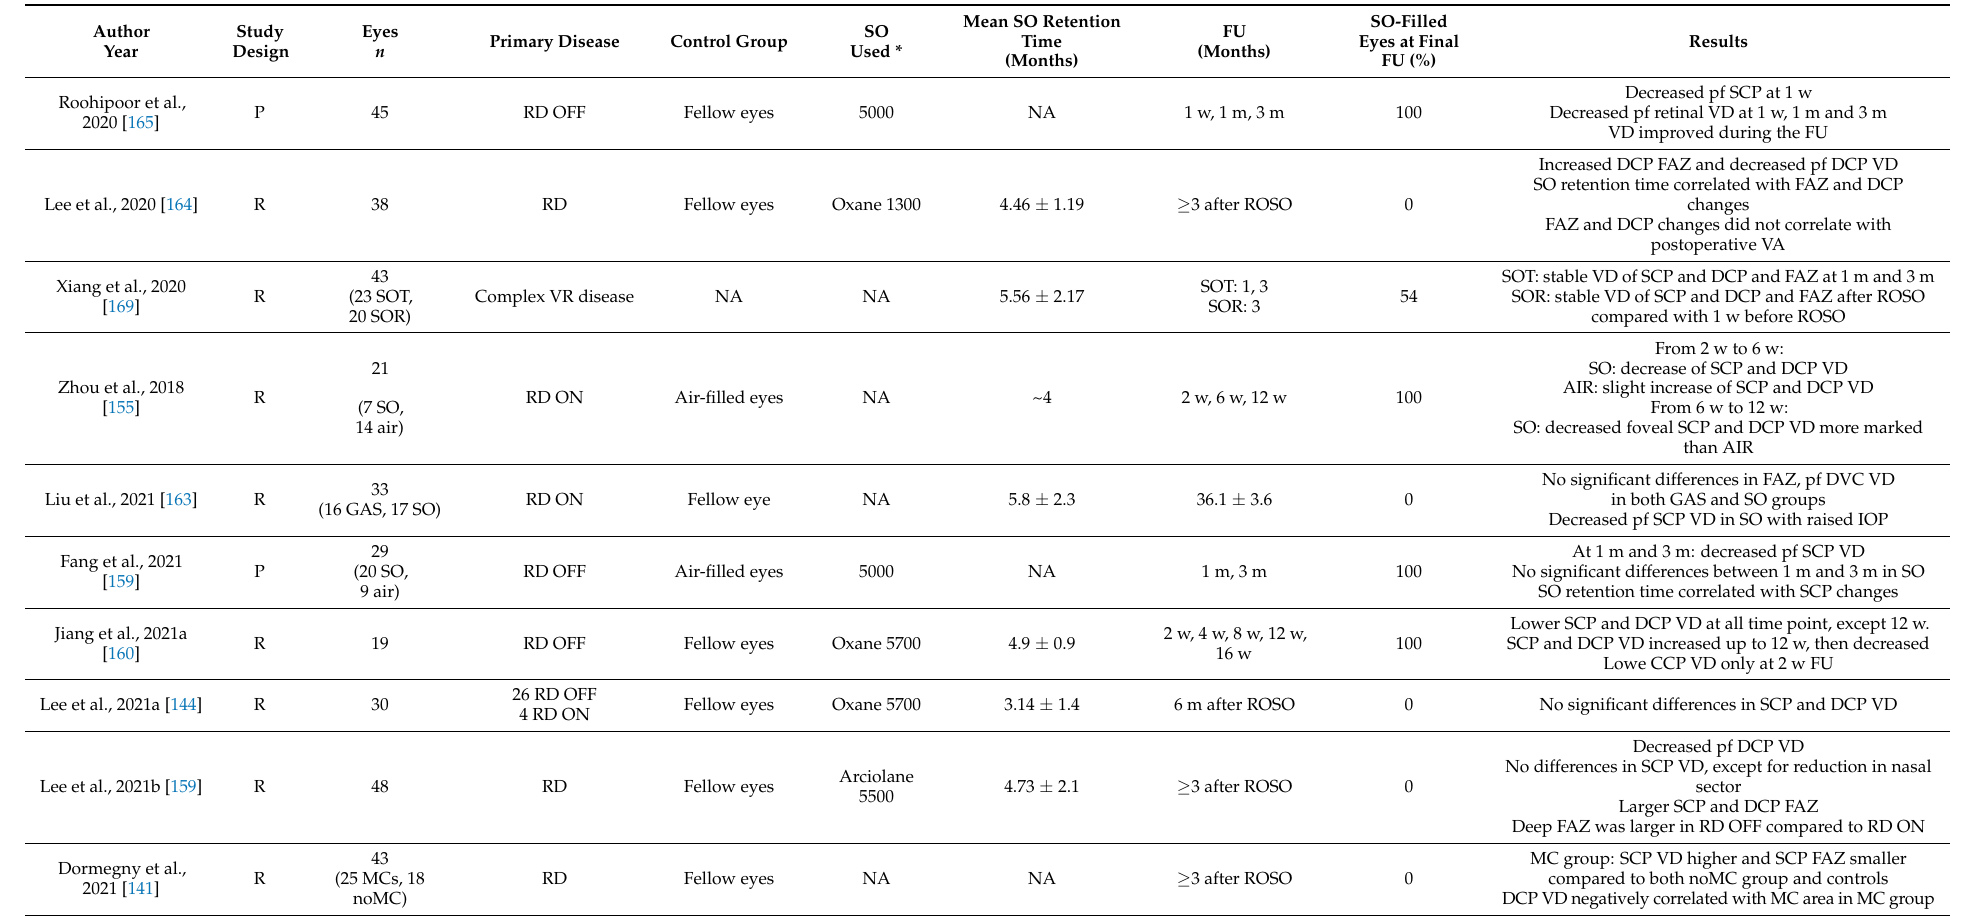
Table 4. Silicone oil-related retinal microvascular changes on